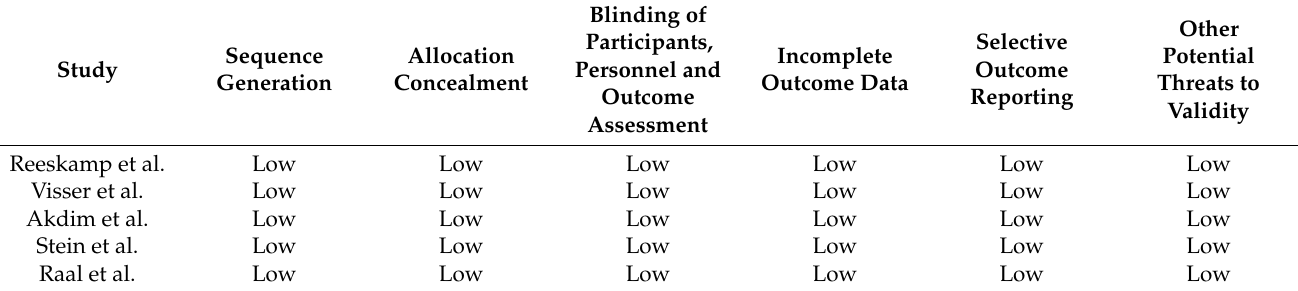
Table 3. Summarized risk of bias in various domains of the included